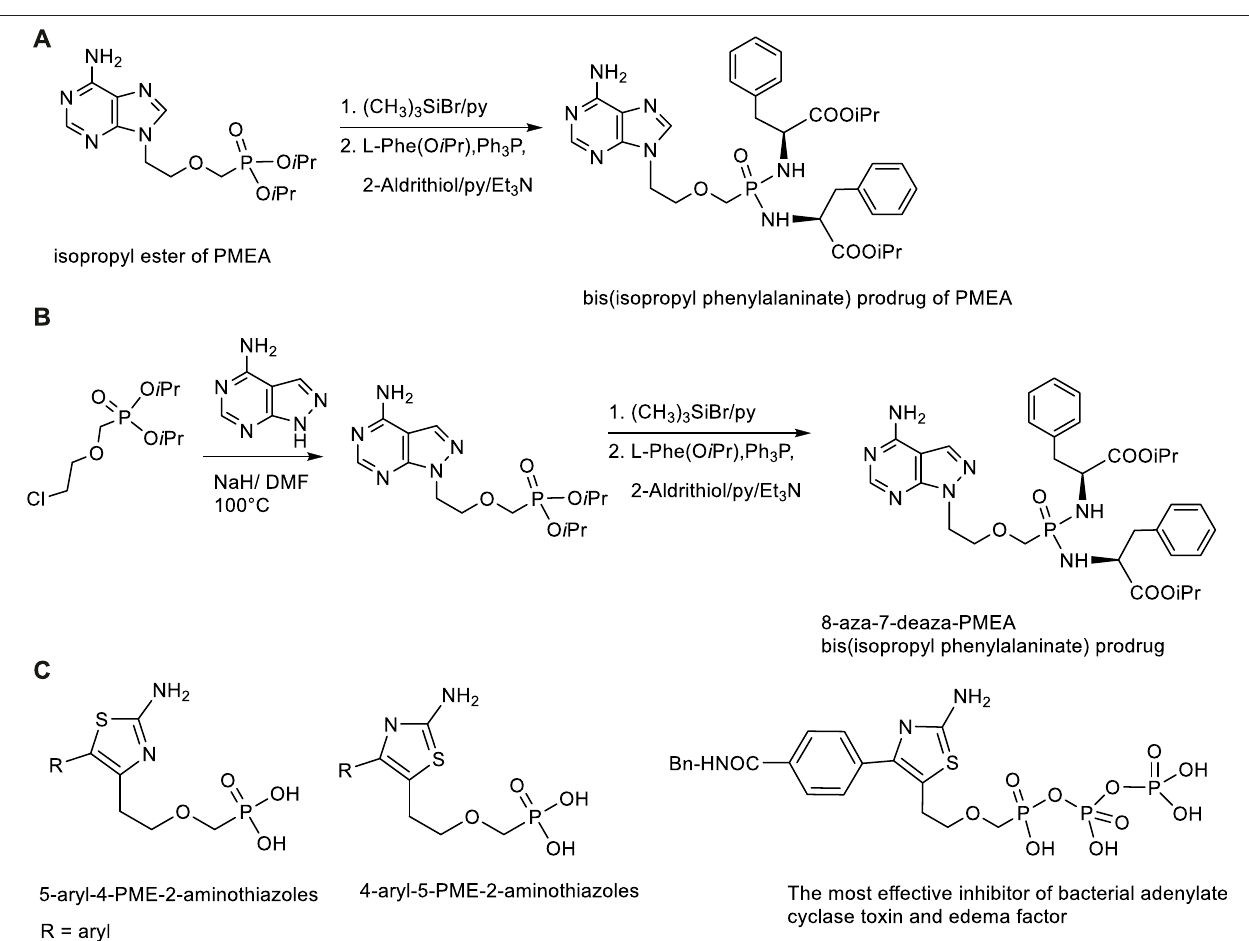
FIGURE 7 | Synthesis and structures of inhibitors of bacterial adenlylate cyclases. (A) Synthesis of bis(amidate) prodrug of adefovir. (B) Synthesis of bis(amidate) prodrug of 8-aza-7-deaza analogue of adefovir. (C) Structures of 5-aryl-4-PME-2-aminothiazoles and 4-aryl-5-PME-2-aminothiazoles.